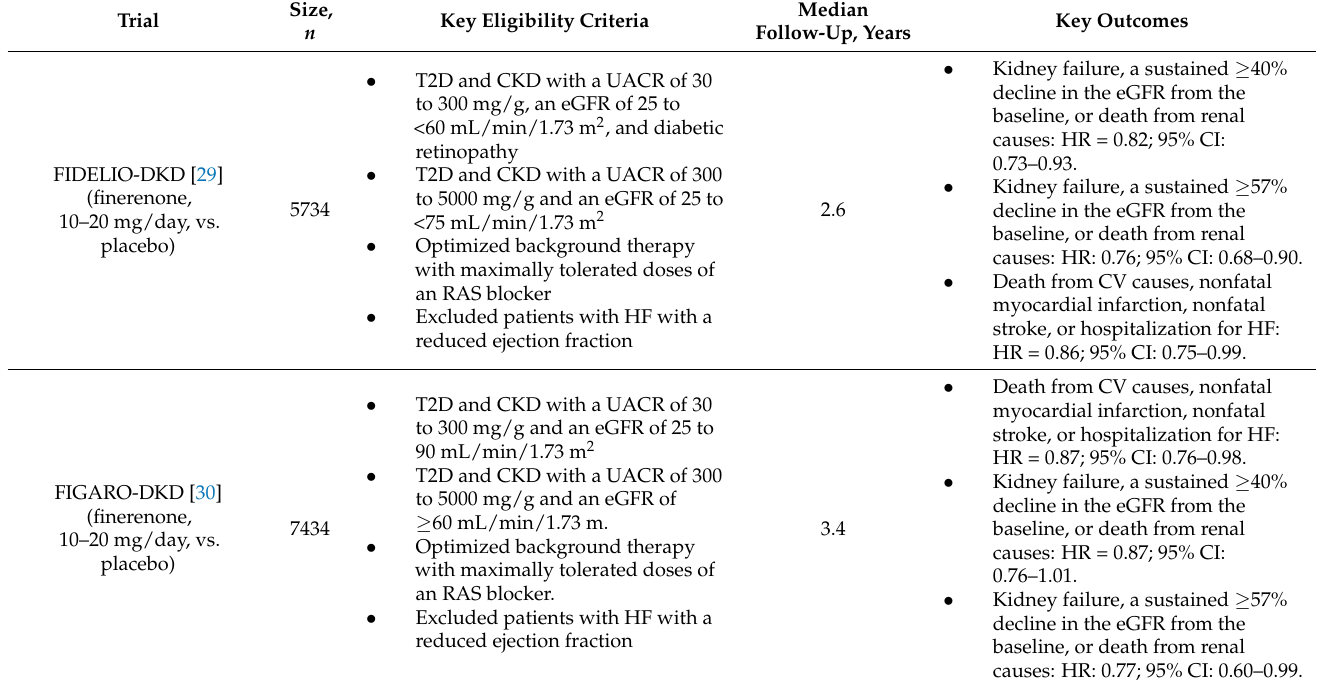
Table 2. Cardiovascular and kidney outcome trials with the nonsteroidal MRA finerenone in patients with CKD and